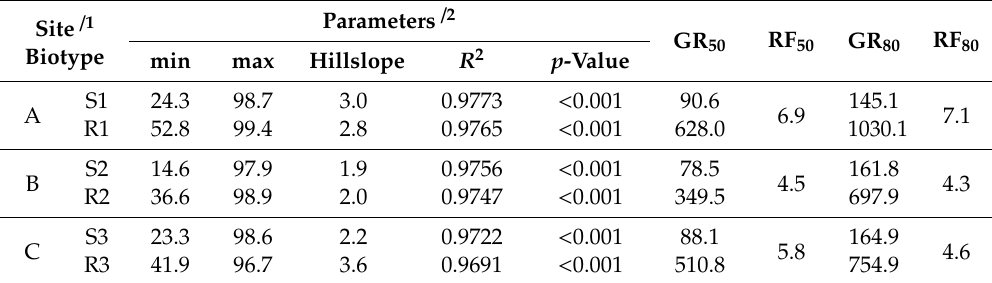
Figure 1. Relation between shoot dry mass and glyphosate dose in dose–response assays for glyphosate-susceptible (S) and -resistant (R) Conyza bonariensis biotypes at 30 days after herbicide application. Seeds were collected in Passo Fundo-RS ( A ), Palmeira-PR ( B ), and Matão-SP ( C ), Brazil. Vertical lines represent the standard error of means ( n = 10). Table 2. Equation parameters, coe ffi cient of determination ( R 2 ), significance of regression ( p -value), and glyphosate doses required to reduce shoot dry mass by 50% (GR 50 ) and 80% (GR 80 ), as well the respective resistance factor (RF 50 and RF 80 ), of glyphosate-susceptible (S) and -resistant (R) Conyza bonariensis biotypes collected from three seed collection sites in